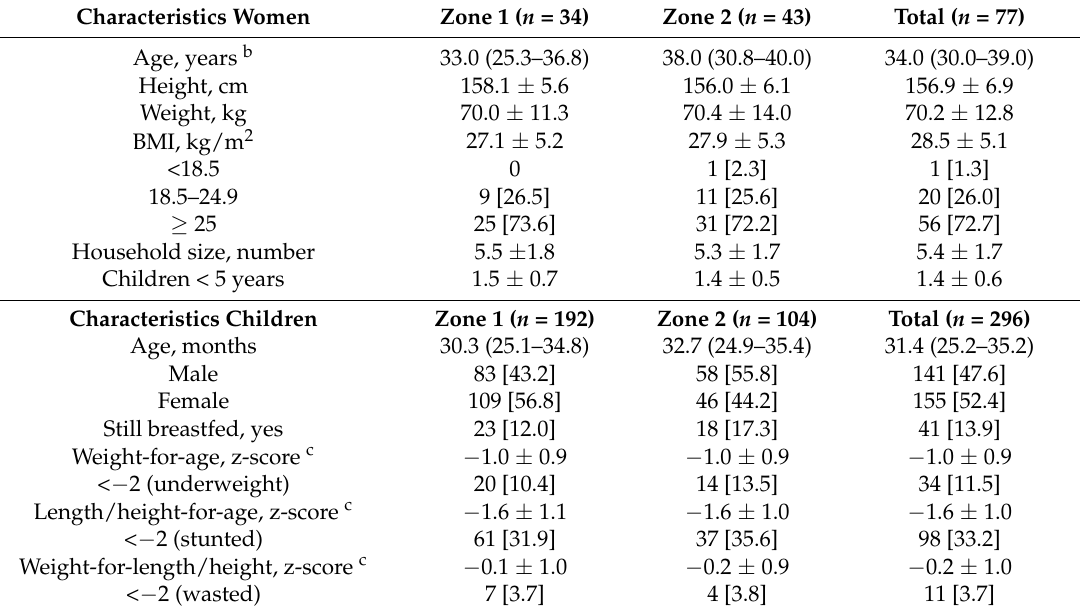
Table 1. Background characteristics of Saharawi women and children a